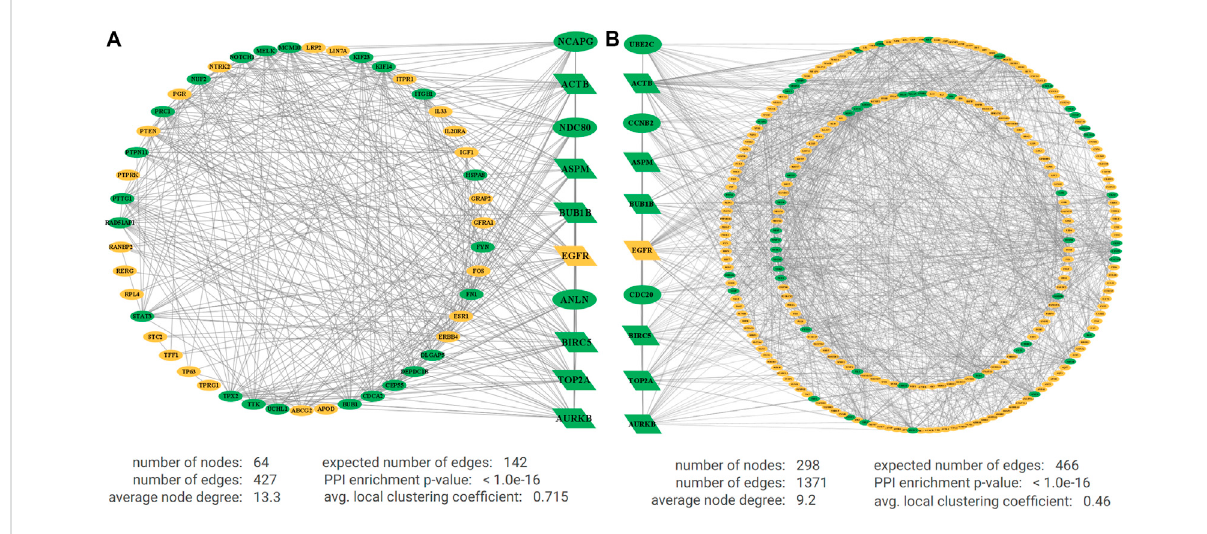
FIGURE 3 Protein – protein interaction (PPI) networks for (A) DEGs for microarray data and (B) DEGs for RNA-Seq data. The green indicates upregulated and yellow indicates downregulated DEGs, and the larger nodes in the center are KGs with the highest degree of